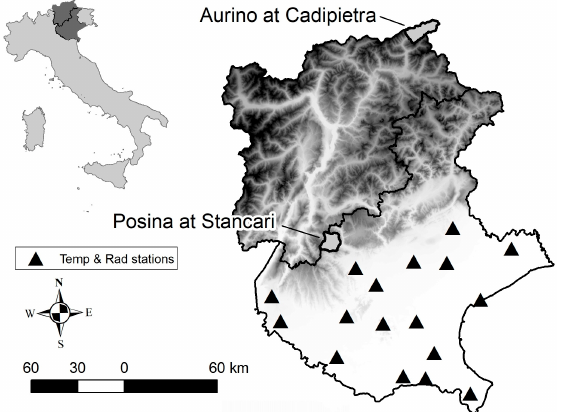
Figure 1. Topographic map of the study region in Northern Italy. The catchments of Aurino at Cadipietra (149.8 km 2 ) and Posina at Stancari (116 km 2 ) are shown by light gray areas. Along the climate transect from the alpine crests to the Veneto plain (dry and snowmelt dominated at high elevations and wet and precipitation dominated at lower elevations), these two catchments represent a benchmark of the opposite locations of hydropower plants in this region. Location of solar irradiance and temperature measurements in the Veneto plain area are indicated by black pyramids.